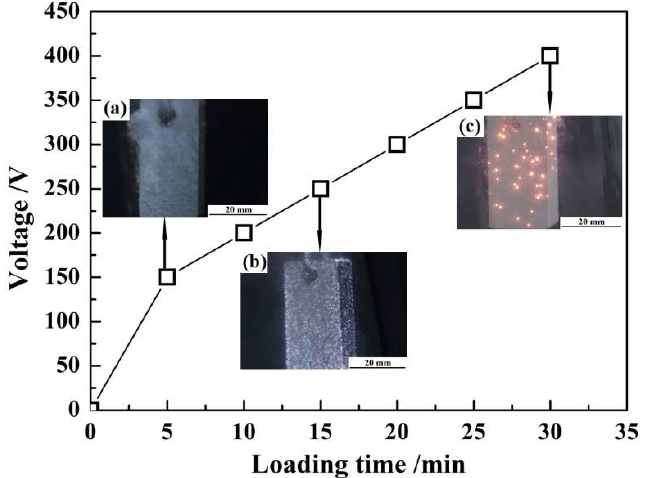
Figure 2. The evolution of arc discharge at the frequency is 500 Hz, the duty cycle is 30% (cooling time is 1.4 ms) and the voltage is ( a ) 150 V, ( b ) 250 V and ( c ) 400 V, respectively.